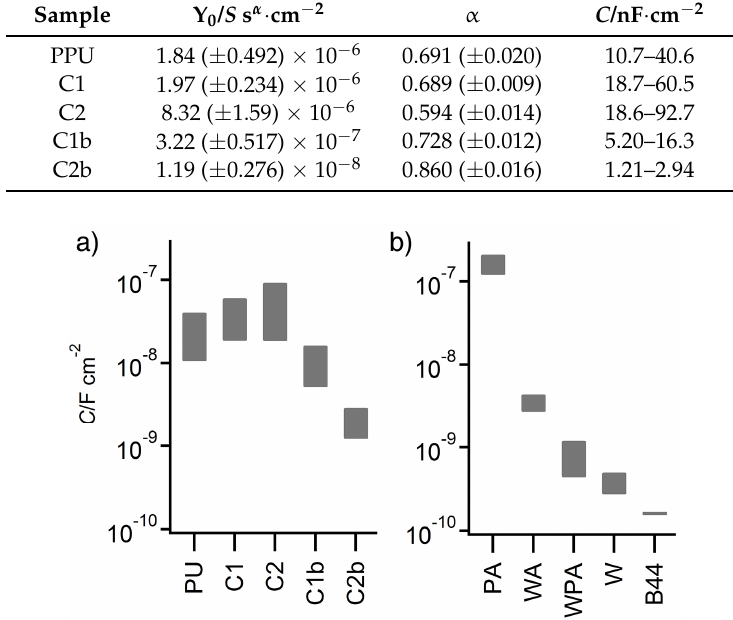
Figure 5. Comparison of calculated coating capacitance ranges for bronze sculptures ( a ) and test panels ( b ). The bars represent the capacitance range calculated using equation 6 at the high and low frequencies listed in Tables 2 and 3 for each sample, including the fitting errors from the CPE parameters.